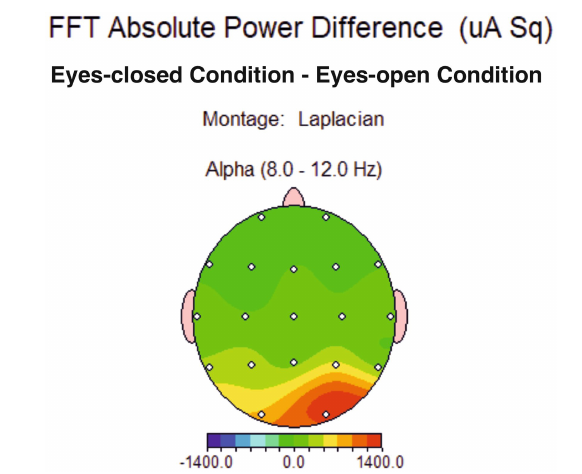
FIGURE 2 Topographical distribution of conventional alpha band average power difference between eyes-closed and eyes-open condition, showing no difference for the alpha band in the two conditions at measured sites (frontal, frontolateral and parietal).